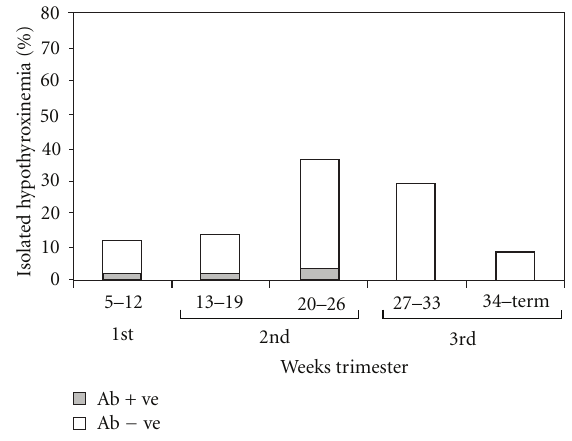
Figure 1: Frequency distribution of isolated hypothyroxinemia over the course of gestation in a series of 220 consecutive pregnant women from a mildly iodine-deficient area (from European Journal of Endocrinology, by Bioscientifica